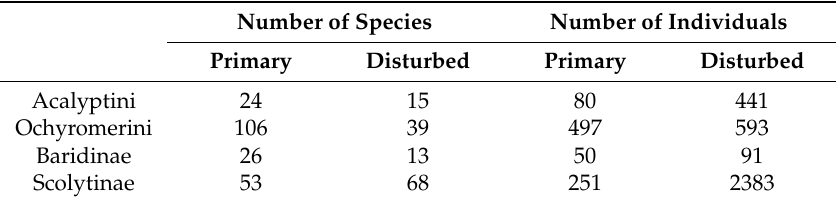
Table 2. Weevil groups showing the most conspicuous differences in individual and species numbers between primary and disturbed